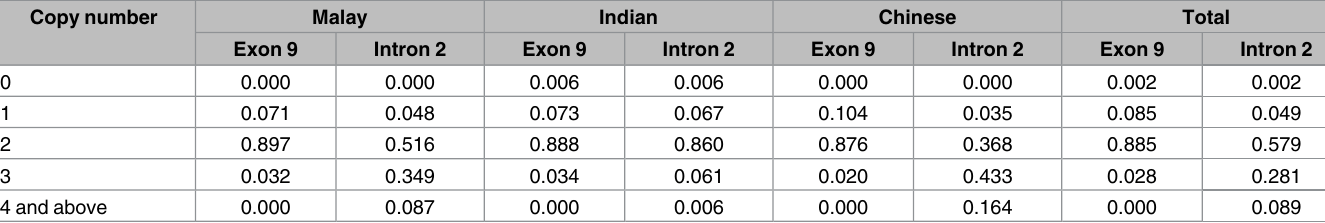
Table 5. Frequencies of CYP2D6 copy numbers in the Singapore population tested. Copy number